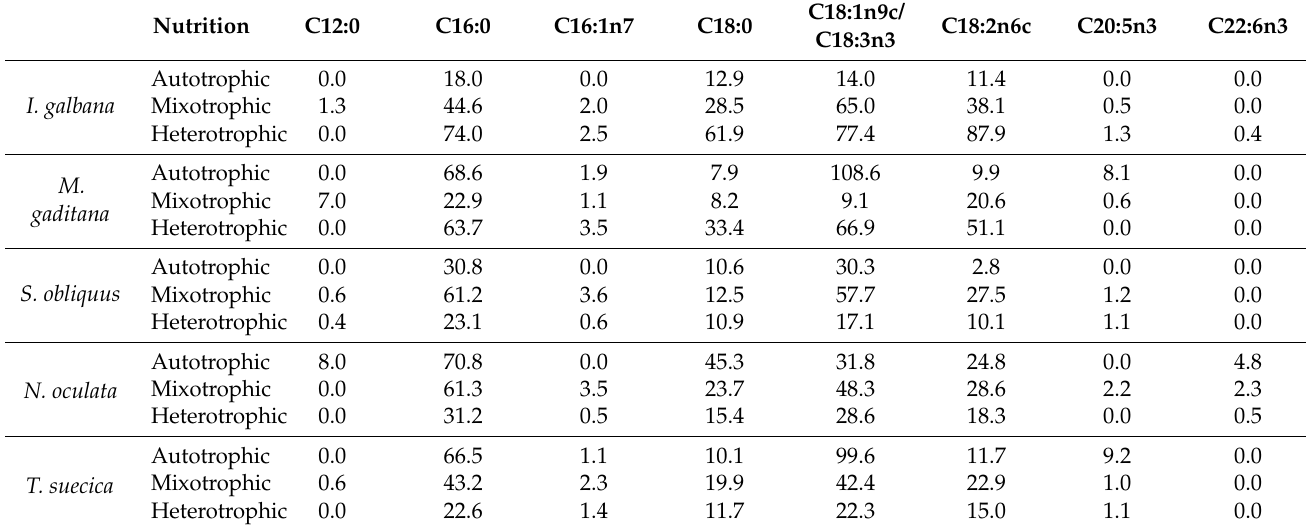
Table 3. Fatty acid profiles (mg · g − 1 of AFDW) obtained from microalgae cultivated under different trophic